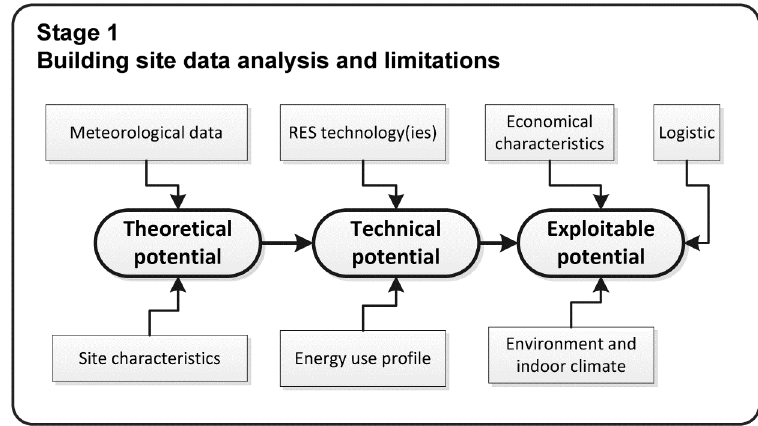
Fig. 2. Detailed description of the first stage